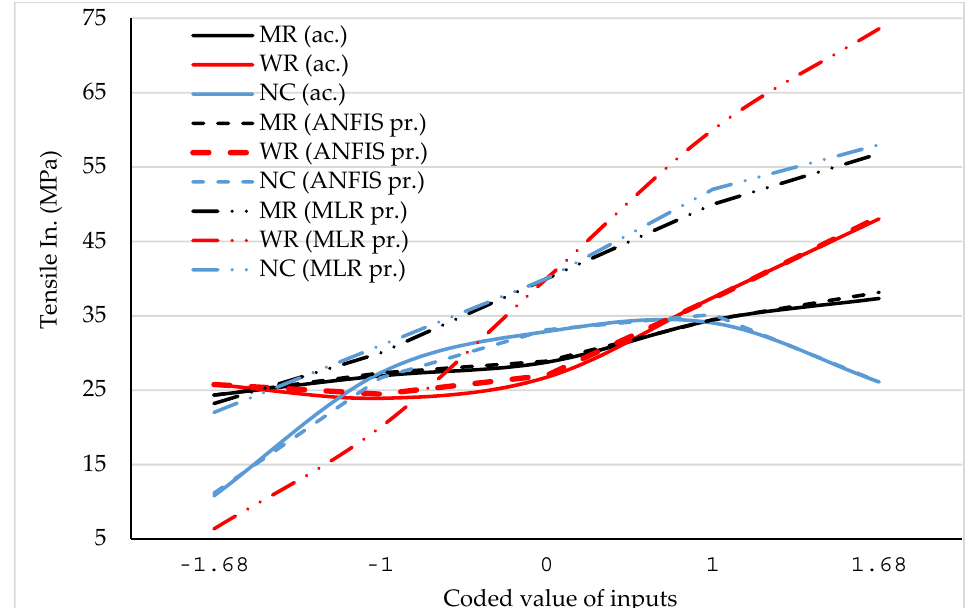
Figure 9. Comparison of the direct effect of independent variables on the actual tensile index values and those predicted by the ANFIS and MLR approaches.